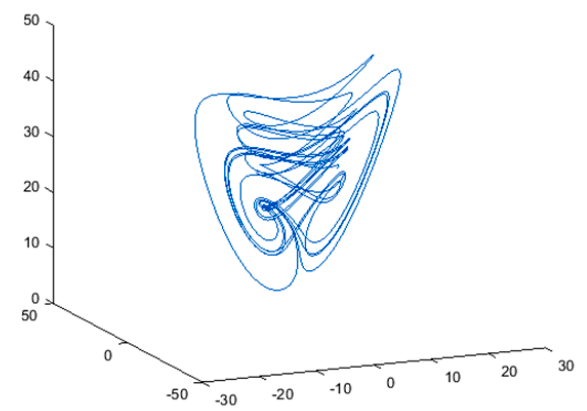
Figure 1. Phase portrait of discrete-time chaotic Chen system.